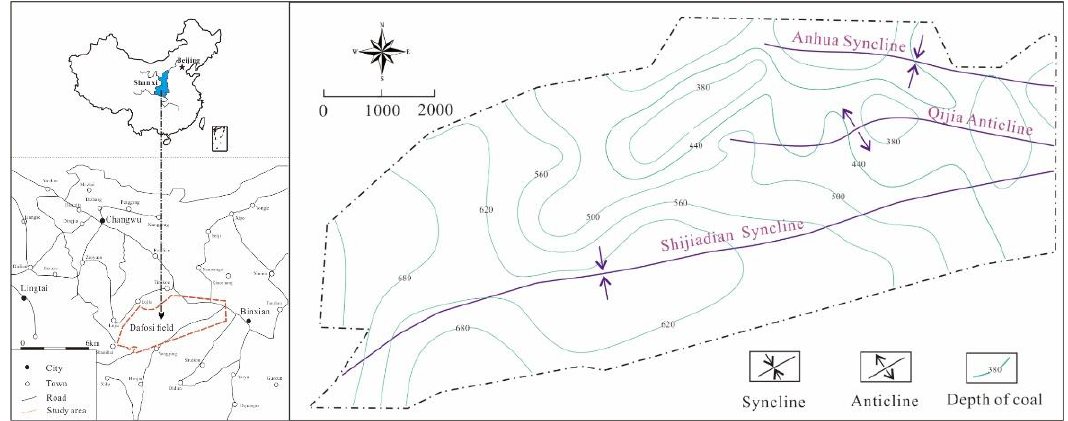
Figure 1. The location and geological structure of the Dafosi field.